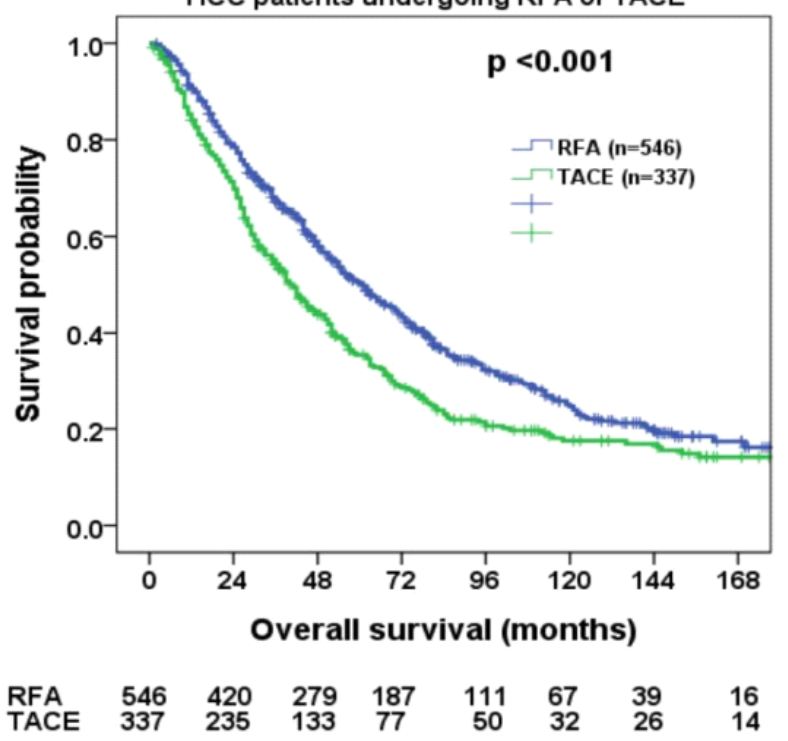
Figure 2. Comparison of overall survival in patients within the Milan criteria undergoing radiofre- quency ablation (RFA) and transarterial chemoembolization (TACE). RFA group had a better survival compared with TACE group ( p < 0.001).